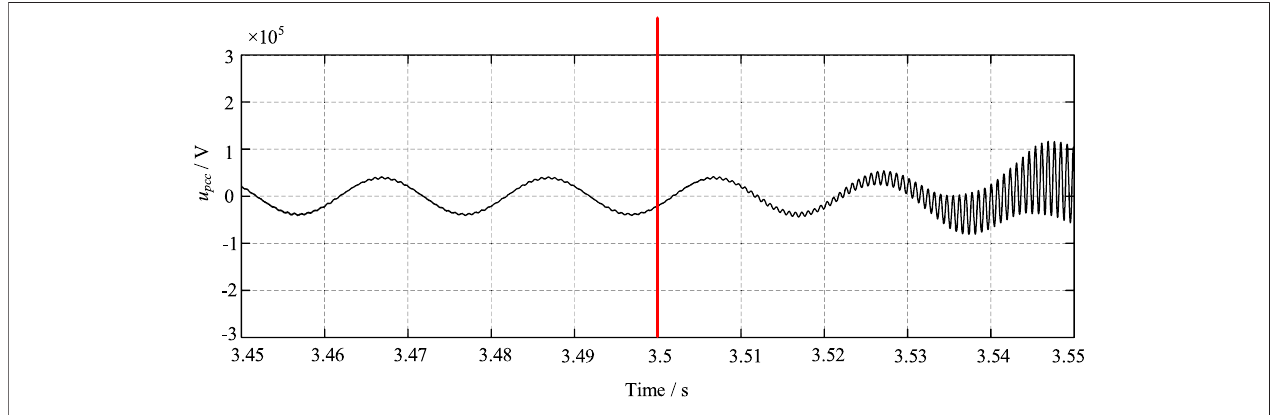
FIGURE 13 | The simulated waveforms of voltage of the PCC for case